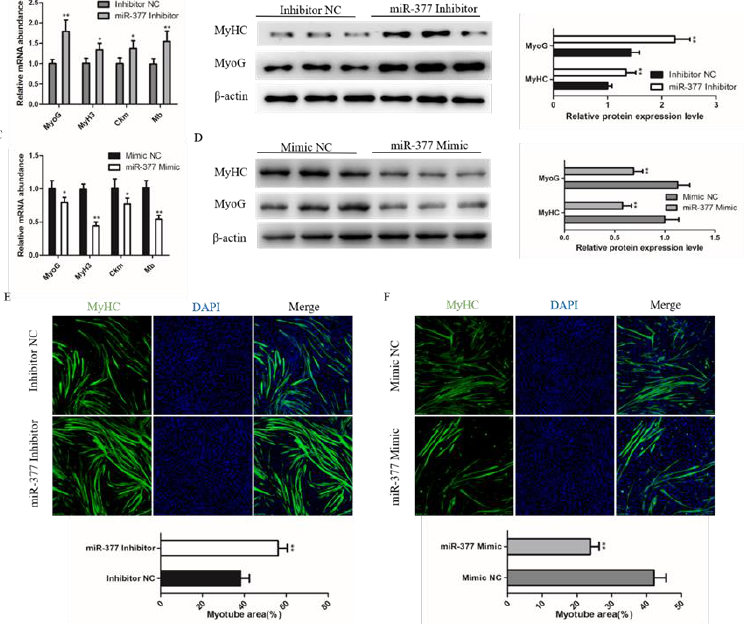
Figure 3. Effect of miR-377 on the differentiation of bovine SMSCs. ( A ) qPCR analysis the expression levels of MyoG, MyH3, Ckm and Mb in inhibitor NC and miR-377 inhibitor cells. ( B ) Western blot analysis the protein levels of MyoG and MyHC in inhibitor NC and miR-377 inhibitor cells. ( C ) qPCR analysis the expression levles of MyoG, MyH3, Ckm and Mb in Mimic NC and miR-377 Mimic cells. ( D ) Western blot analysis the protein levels of MyoG and MyHC in Mimic NC and miR-377 Mimic cells. ( E ) SMSCs transfected with inhibitor NC and miR-377 inhibitor were induced differentiate for 72 h then stained with MyHC antibody and DAPI. The lower histogram represents the myotube area. ( F ) SMSCs transfected with Mimic NC and miR-377 Mimic were induced differentiate for 72 h then stained with MyHC antibody and DAPI. The lower histogram represents the myotube area. Data are expressed as mean ± SEM ( n = 3). * p < 0.05; ** p < 0.01. 3.4. miR-377 Directly Target FHL2 and Inhibit Its Expression To investigate the mechanism of miR-377 inhibiting proliferation and differentiation of bovine SMSCs, we used TargetScan as a gene prediction program to identify proliferation and differentiation-related genes containing miR-377 response elements in 3′-UTR. The results showed that FHL2 is a candidate target of miR-377, and studies have shown that miR-377 has effects on proliferation and differentiation. In order to confirm this result, a destabilizing mutation was introduced into the predicted binding sites (Figure 4A). Luciferase results showed that exogenous miR-377 reduced luciferase activity in SMSCs cells transfected with 3-UTR FHL2 but had no effect on luciferase activity of mutated FHL2 3-UTR (Figure 4B). We found that both mRNA and protein levels of FHL2 were significantly reduced after transfection with miR-377 mimic, while transfection with miR-377 inhibitor significantly promoted the expression of FHL2 (Figure 4C–E). These results indicate that FHL2 is a validated target of miR-377 in bovine SMSCs.